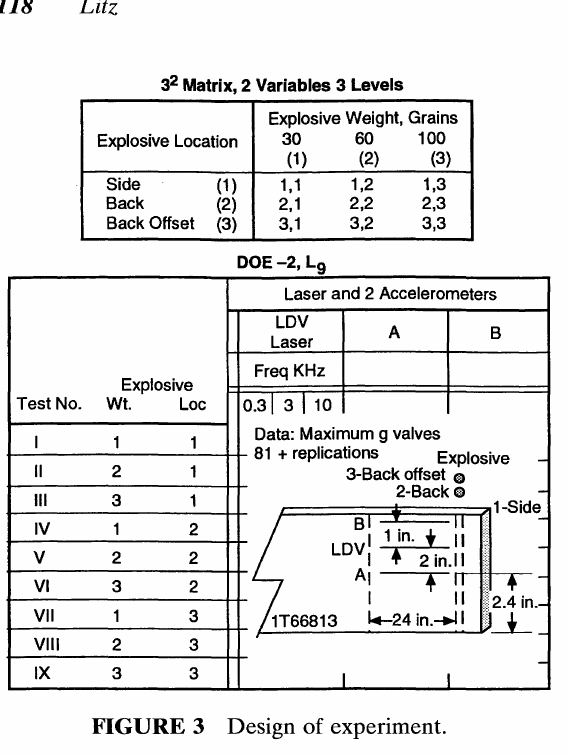
FIGURE 3 Design of